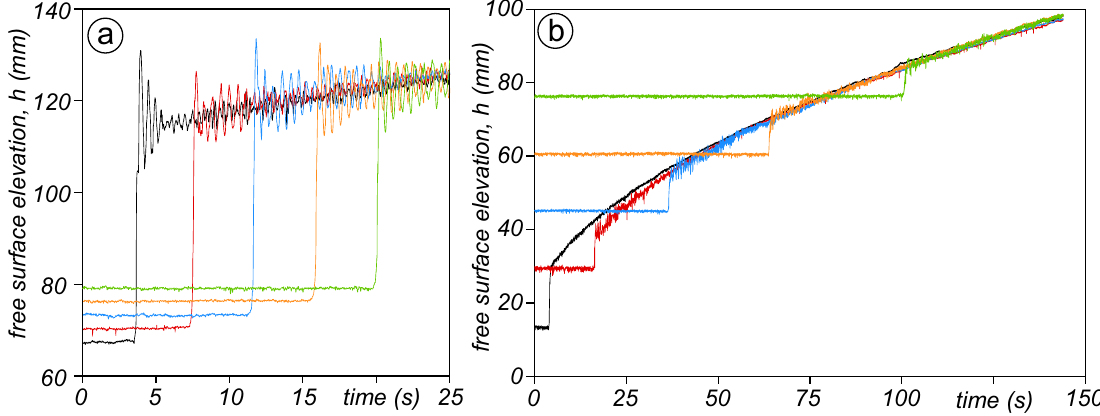
Figure 4. Free surface elevation, h , measured by the five ultrasonic probes. ( a ) run 20 ( s = 0.001, Y 0 = 0.073 m, U 0 = 0.50 m/s, F 0 = 0.59); ( b ) run 33 ( s = 0.0052, Y 0 = 0.011 m, U 0 = 0.43 m/s, F 0 =